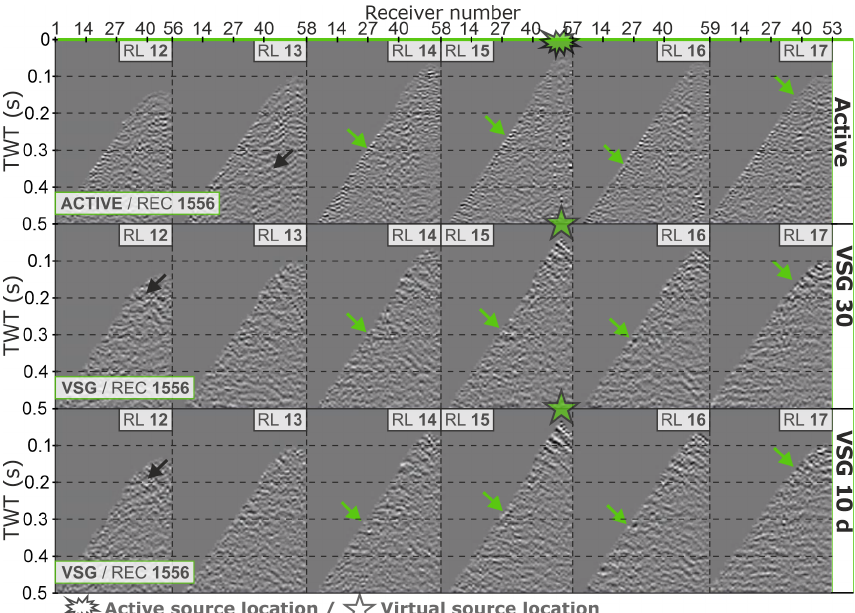
Figure 7. Comparison of exemplary co-located 3D common-source gathers using active and passive data. The active-shot gathers are filtered using a bandpass filter (25–35–90–120Hz) to have the frequency content of the passive data. For each gather, we show six receiver lines (RLs). Common-source gathers co-located with receiver station 1556: (top row) active-shot gather, (middle row) VSGs obtained using 30d of noise, and (bottom row) VSGs obtained using 10d of noise. The green arrows on both active and passive data highlight the position of reflection arrivals observed in active-source data and projected on co-located VSGs. Black arrows indicate artifacts characteristic for passive data. TWT stands for two-way travel